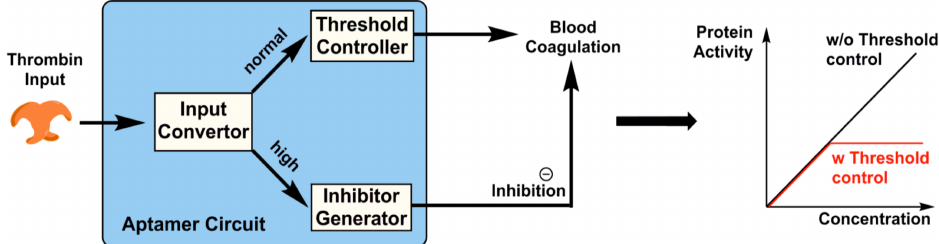
Figure 2. The working principle of aptamer based molecular circuit. The circuit’s three interconnected modules could be programmed to control the activity of the protein [63]. The molecular circuit operated by series of strand-displacement reactions followed by aptamer-protein recognition